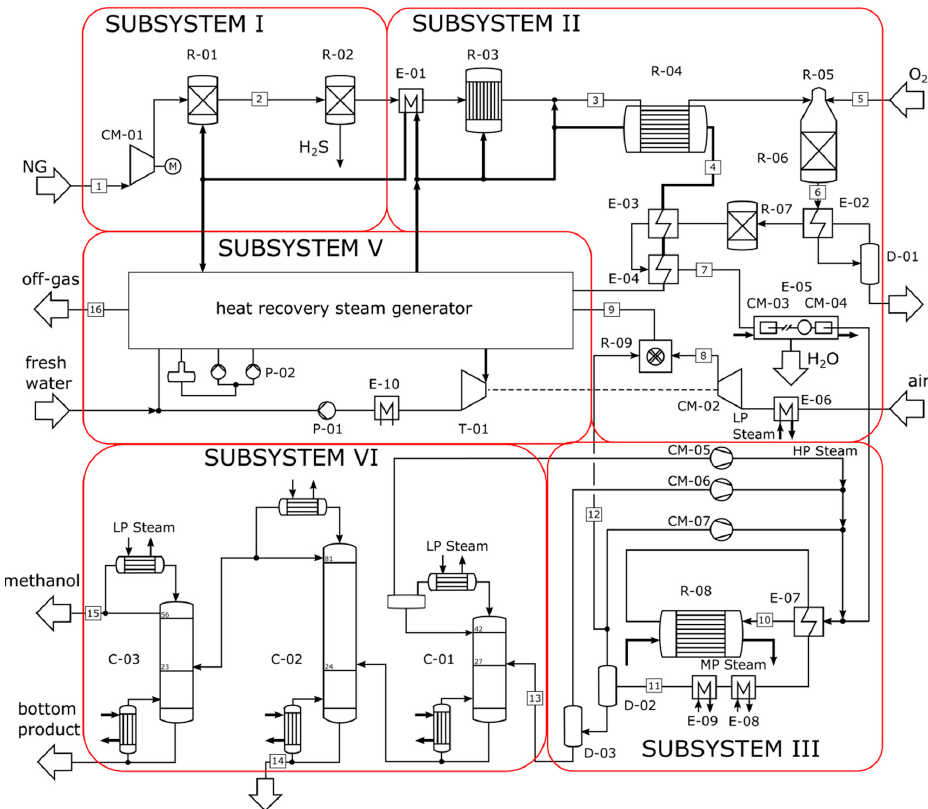
Figure 4. Process flow sheet of the methanol plant with steam-methane and autothermal reforming in serial configuration (Case II). Table 4. Stream data of the methanol plant with steam–methane and autothermal reforming in serial configuration (Case II).